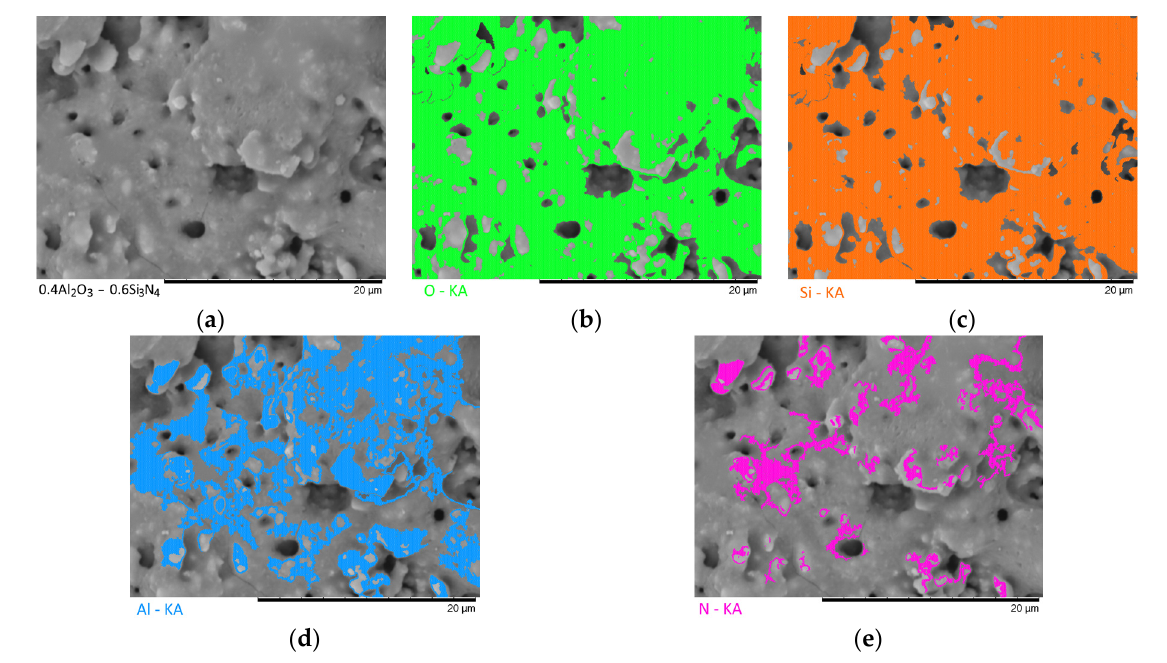
Figure 4. Results of morphological studies and mapping of a ceramic sample with an Al 2 O 3 content of 0.4 mol: ( a ) SEM image; ( b ) oxygen distribution results; ( c ) silicon distribution results; ( d ) aluminum distribution results; ( e ) nitrogen distribution results.